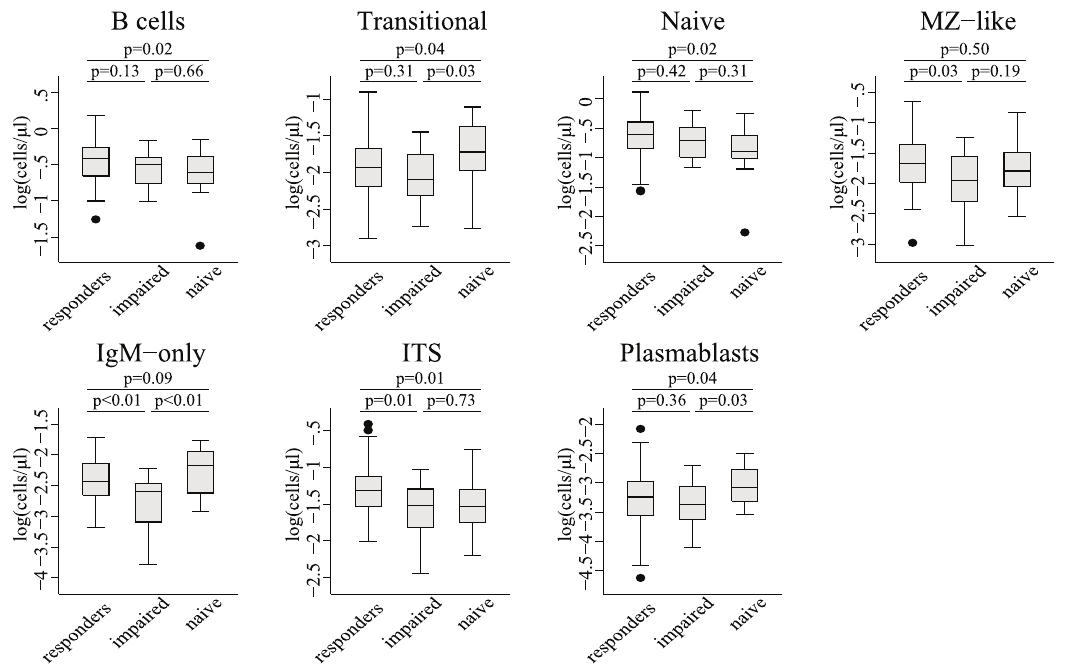
Figure 1. Pre-vaccination difference in B cell subpopulations between patient groups: the impact of successful ART. Box plots showing the absolute cell count of B-cell populations in the three patient groups (naı¨ve; never treated with antiretroviral therapy (ART), impaired; ART for a minimum of 3 years, and still not achieving a CD4 T cell count above 500 cells/ml, responders; ART and a CD4 T cell count above 500 cells/ml). The vertical axis displays the logarithmic transformed cell count in cells/ul, and the horizontal line in the box indicates the median value of the group; whiskers illustrate the interquartile ranges. Populations are compared using a Student’s T-test and p-values express the level of significant difference between groups. One outlier has been removed from the plasmablasts. This ART-naı¨ve patient had a value of 2 4.20 log(cells/ m l).